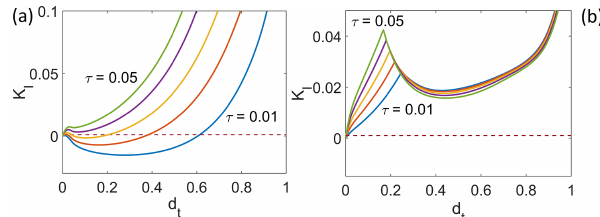
Figure 2. Scaled stress intensity factor versus the crack length for different values of scaled extensional stress: τ = 0 . 01 (blue), τ = 0 . 02 (red), τ = 0 . 03 (yellow), τ = 0 . 04 (purple) and τ = 0 . 05 (green), for (a) scaled water level depth η = 0 . 04 and (b) scaled wa- ter volume β = 0 . 01, without the contact condition. Fracture tough- ness κ = 0 . 001 is shown as a dashed maroon line. Panel (a) is quali- tatively equivalent to Fig. 10 in van der Veen (1998a) and Extended Data Fig. 5 in Lai et al.